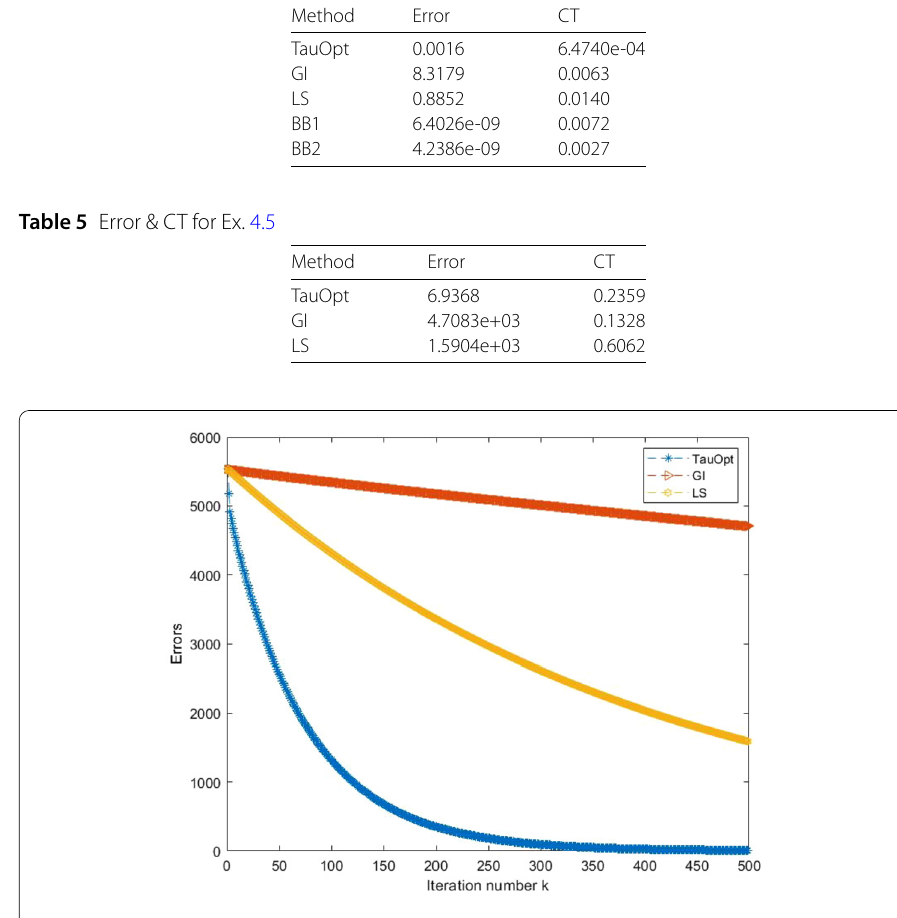
Figure 5 Relative errors for Ex.